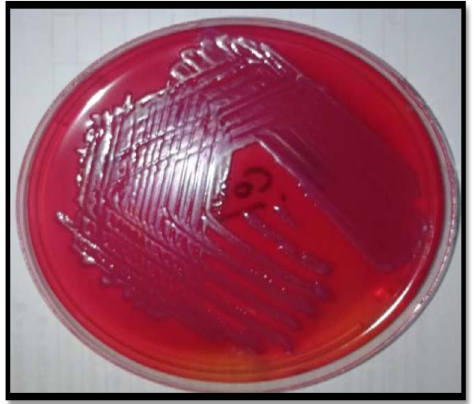
Fig. 1. Identification of E.coli in MacConkey agar